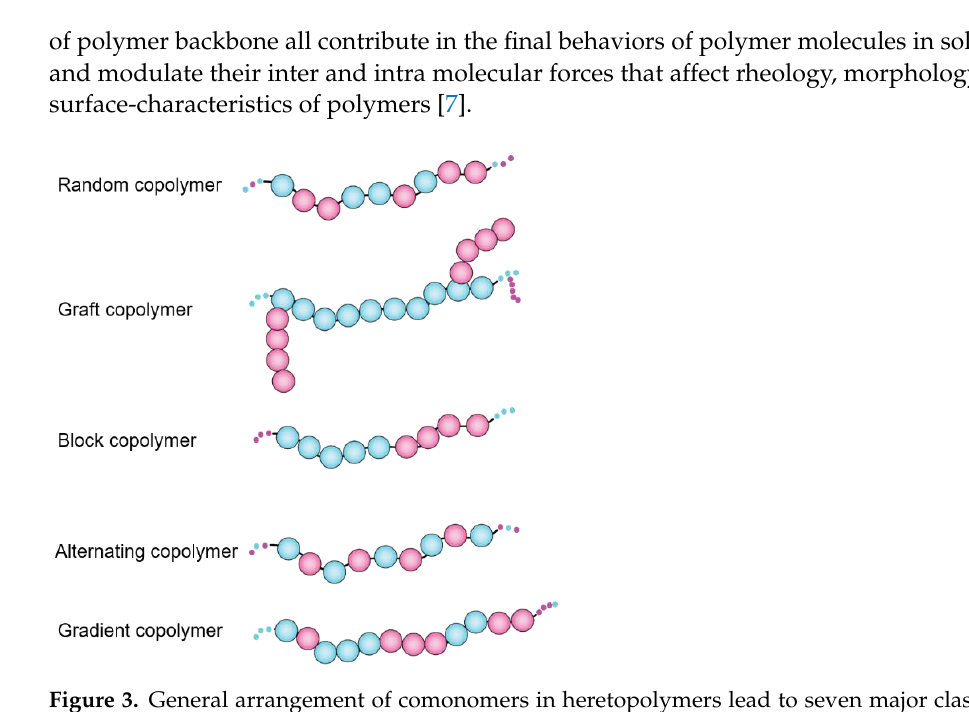
Figure 3. General arrangement of comonomers in heretopolymers lead to seven major classes of amphiphilic polymers. amphiphilic